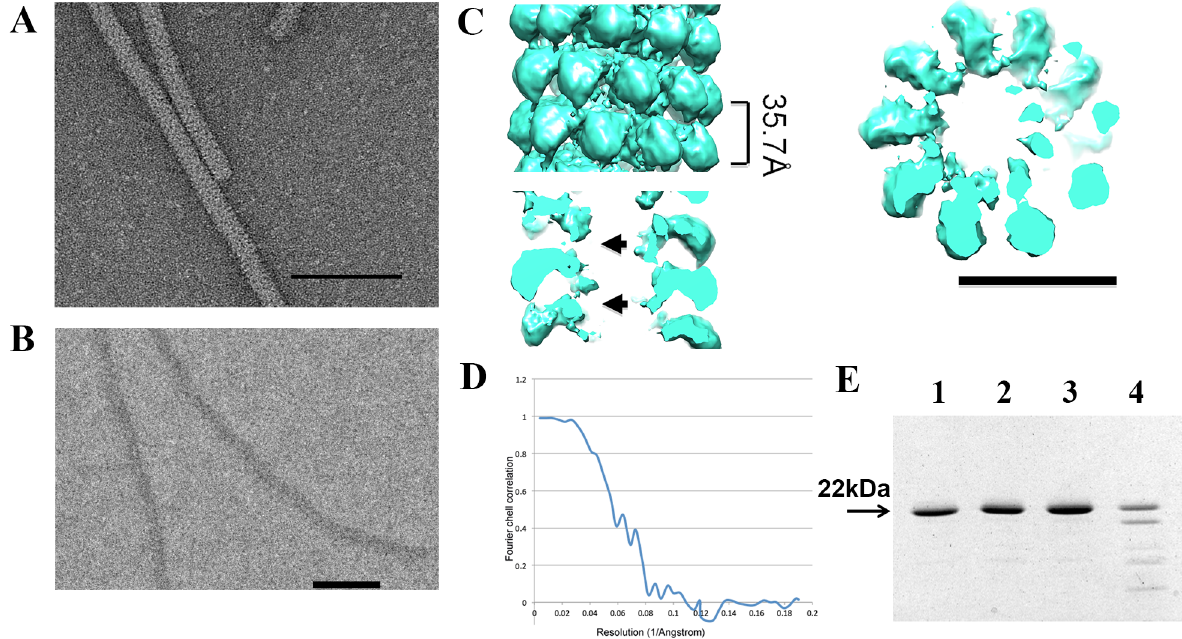
Fig 2. EM analysis of AltMV virus-like particles (VLPs). A. TEM of AltMV VLPs. Samples were stained with 2% uranyl acetate. Bar– 100 nm. B. Cryo-electron microscopy of AltMV VLPs. C. 3D reconstruction: on the left– surface of AltMV VLP, on the right– horizontal slice of AltMV VLP, below –vertical slice of AltMV VLP. Arrows are pointingto the absence of the density, associatedto the viral RNA in Fig 1. D. FSC curve. E. Structure analysisby trypsin treatment. 1 – AltMV virions, 2 –AltMV virions treated by trypsin, 3 –AltMV VLPs, 4 – AltMV VLPs treated by trypsin. All samples contained2 μ g of material. Analysis in 8–20% SDS-PAGE, gel was stained with Coomassie G-250.